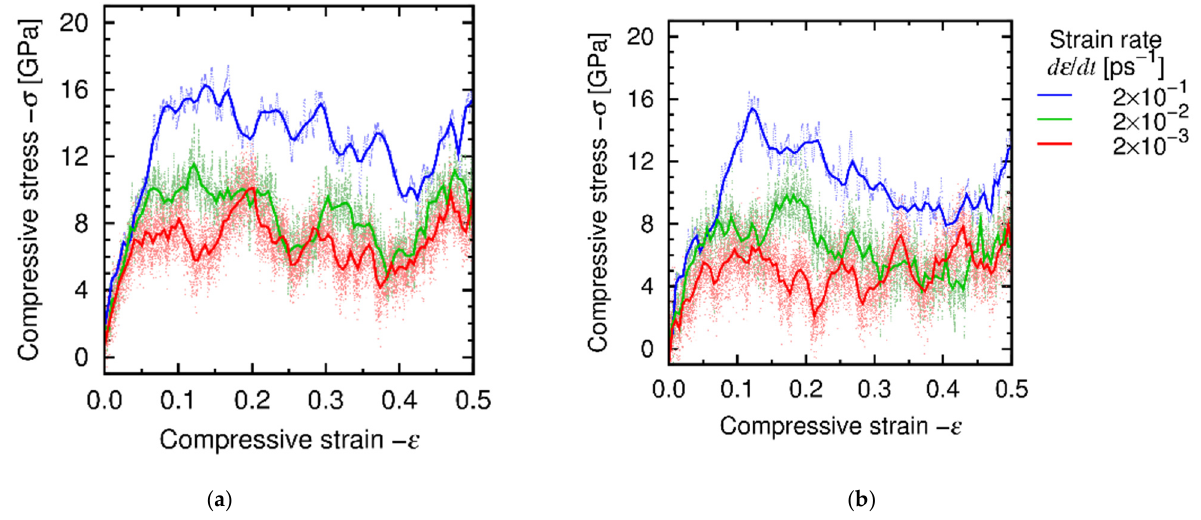
Figure 8. True stress-strain relationships under the d ε / dt -constant conditions at ( a ) T = 1000 K and ( b ) T = 1500 K. The solid curves indicate the Bezier approximation.